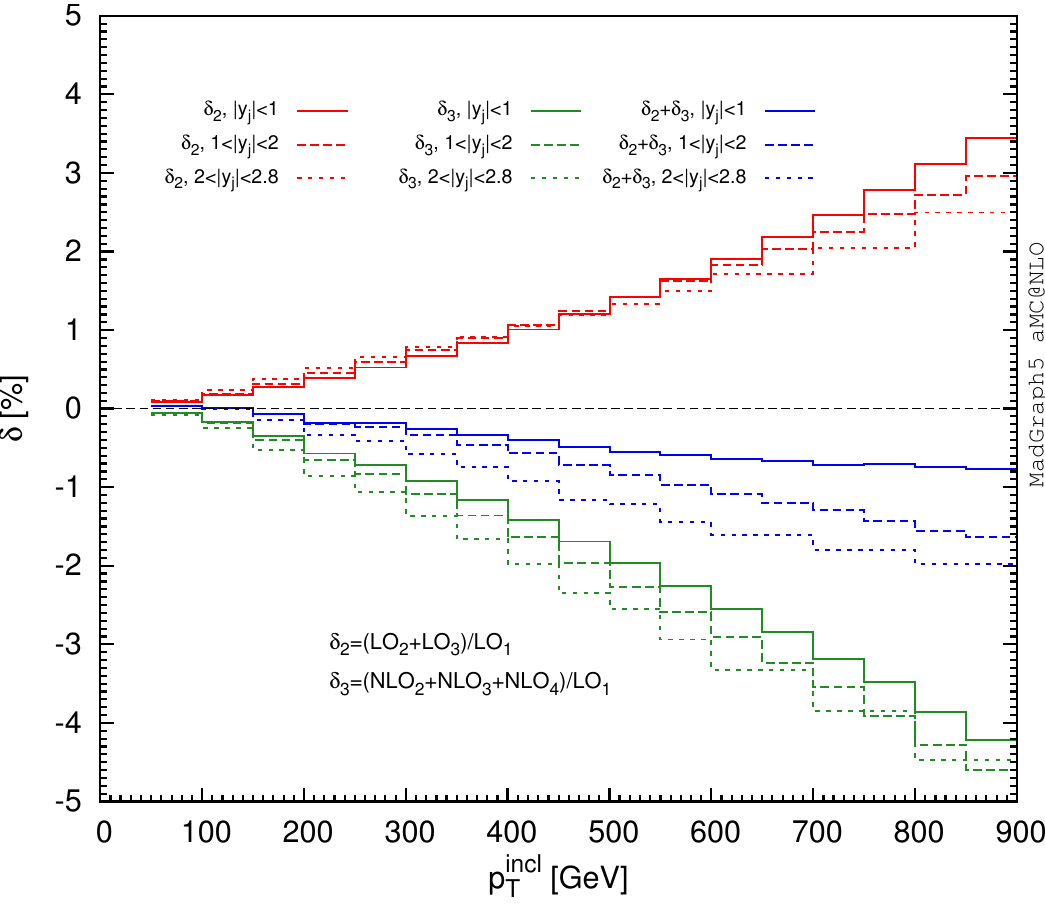
Figure 10 . Single-inclusive transverse momentum; (cid:14) 2 and (cid:14) 3 predictions for the three rapidity regions already considered in (cid:12)gures 5, 7, and